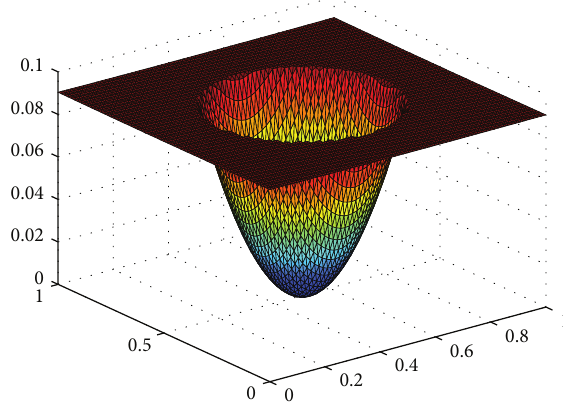
Figure2:Thenumericalsolutionona 64×64 uniformmeshfor 𝛽 1 : = 1: 𝛽 2